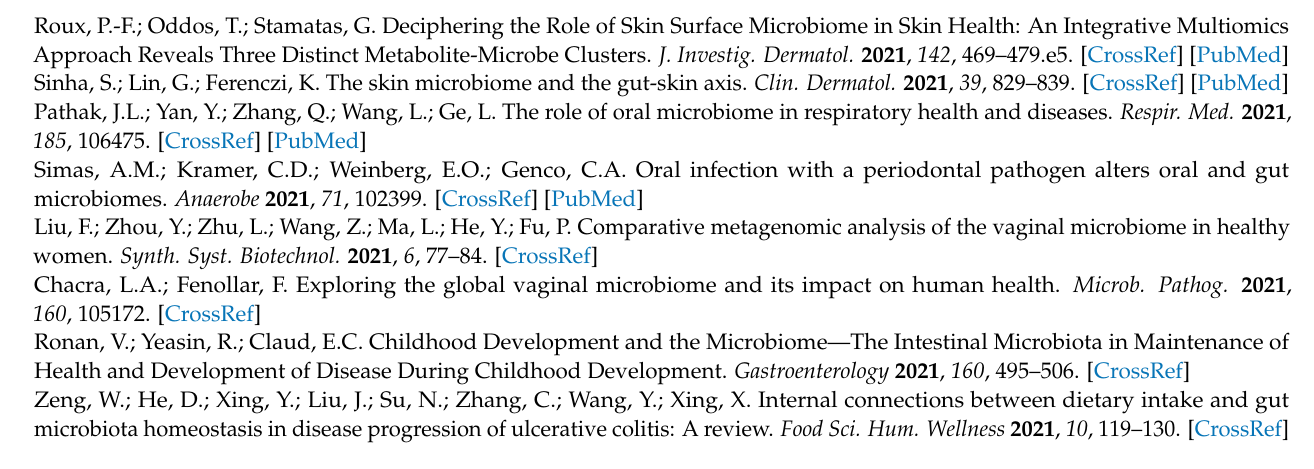
Unifrac PCoA graph of 16S samples separated by fermentations, Figure S3: Jaccard PCoA graph of virome samples separated by fermentations, Figure S4: Weighted Unifrac PCoA graph of all 16S samples, Figure S5: Jaccard PCoA graph of all virome